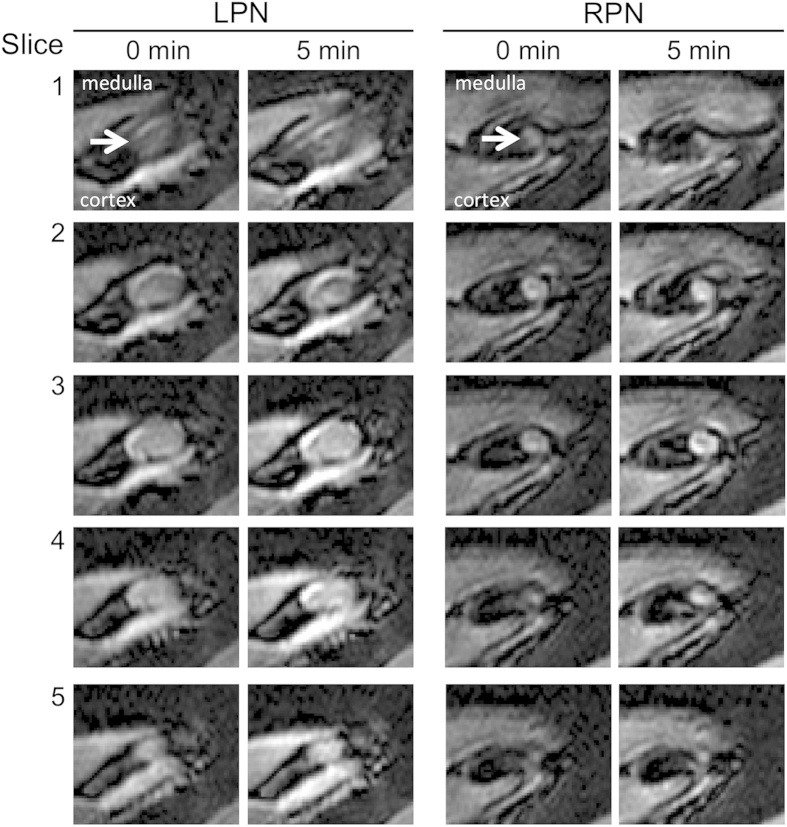
Slice-by-slice illustration of Gd-LNP uptake distribution through lymph nodes.Serial images sampled through the entire left and right popliteal LNs before and 5 min after subcutaneous injection of Gd-LNP. Comparison of pre- and post-contrast images show Gd-LNP enhancement in the medulla and cortex of the LPN, while contrast uptake is more restricted to the cortex of the RPN of all slices. Arrows indicate the popliteal LNs. Note that the RPN images have been flipped vertically to facilitate comparison of the LPN and RPN anatomy.